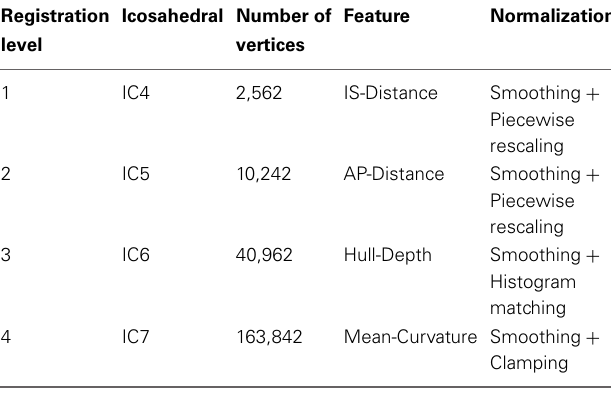
Table 1 | Surfaces and features used for multi-resolution registration.